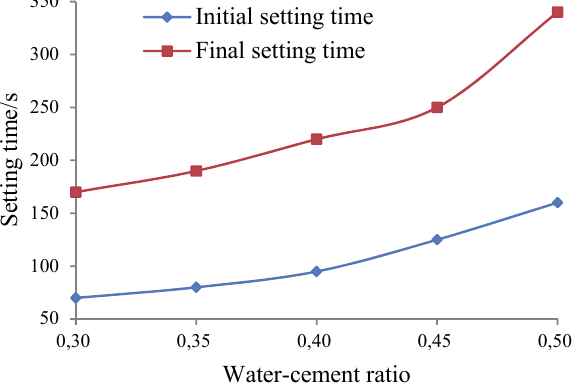
Figure 2: Water-cement ratio change curves of initial and final setting